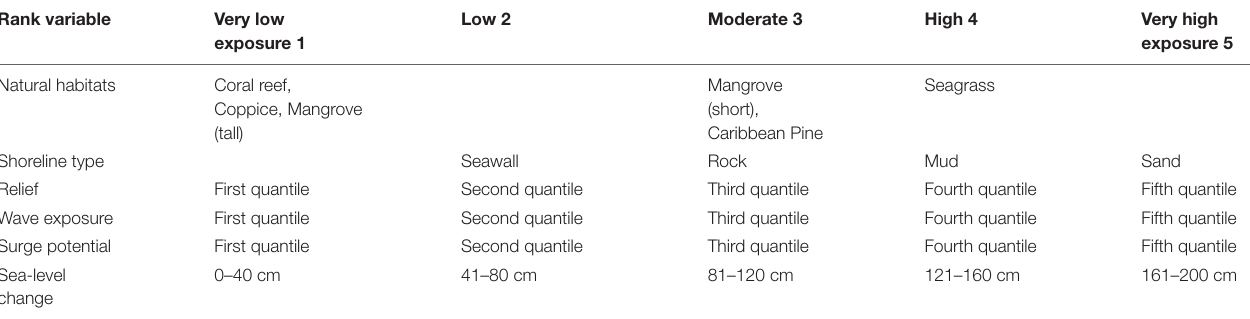
TABLE 1 | Coastal hazard index variables and